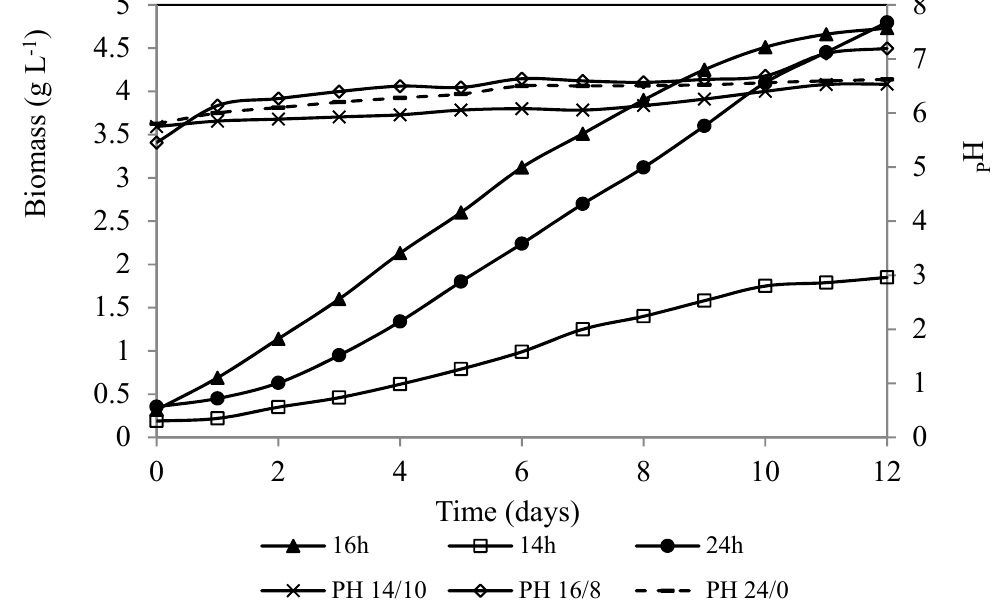
Figure 8. E ff ect of the light / dark cycles on growth of S. Figure 8. Effect of the light/dark cycles on growth of S. dimorphus.